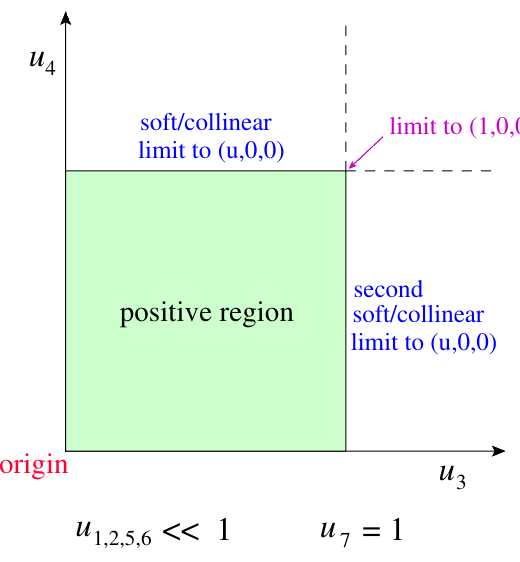
Figure 1 . The plane in u 3 , u 4 de(cid:12)ning the CO